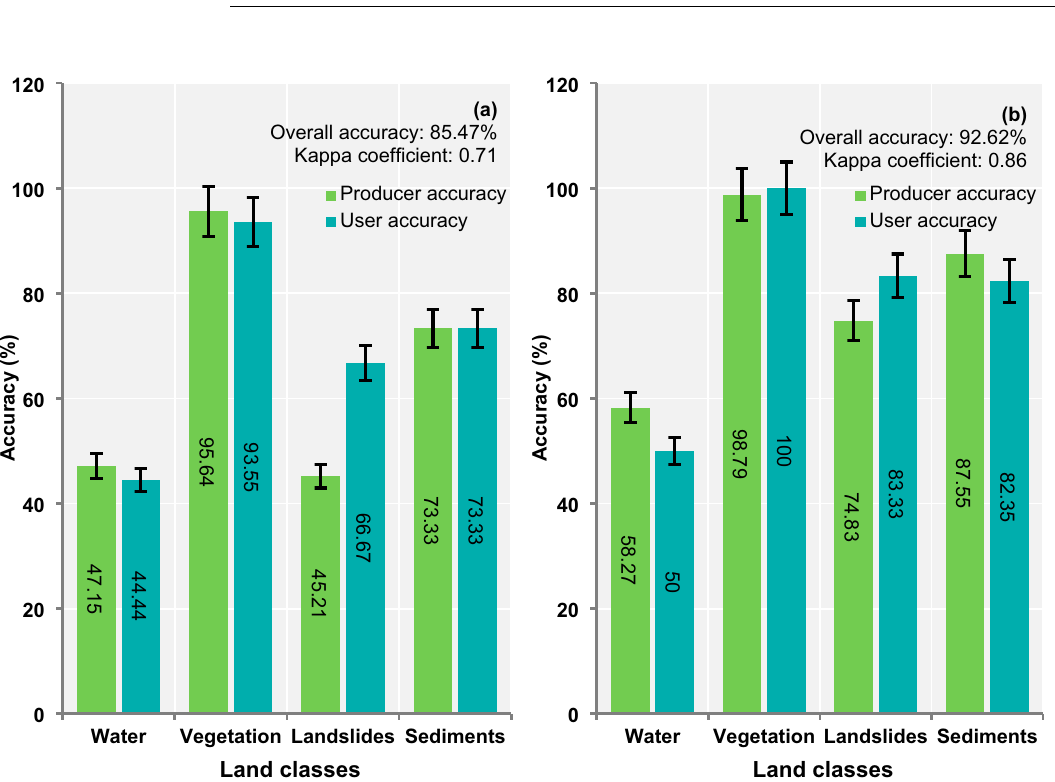
Fig. 9 Accuracy assessment plot, a ISODATA, b RF